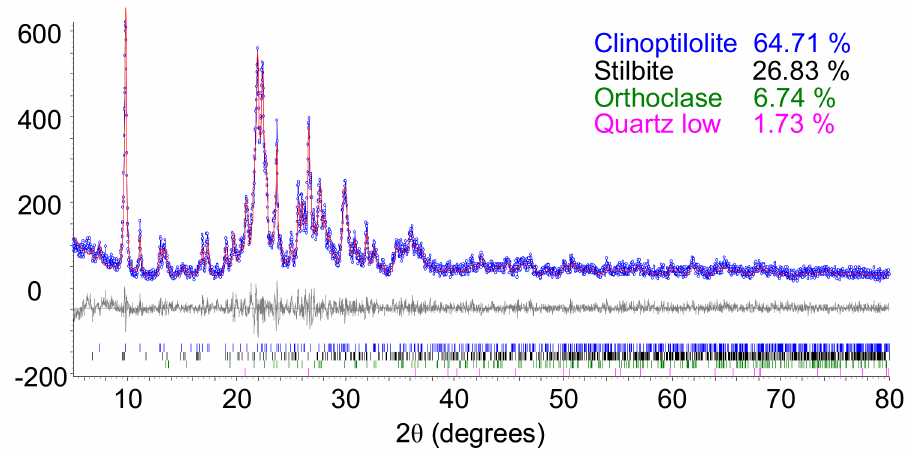
Figure 4. XRD patterns of the raw zeolite showing nice match (black curve around y = 0) between the observed (pint curve) and fitted (blue circles) data. The vertical lines above the x -axis are for the reflections of the four mentioned